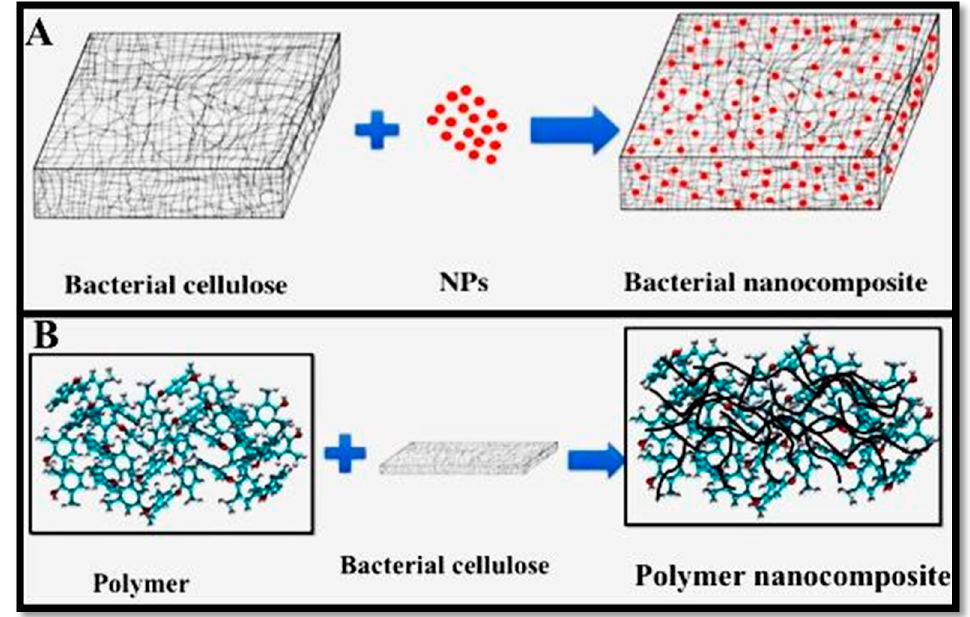
Figure 4. The use of BC as a ( A ) matrix or ( B ) reinforcement to prepare nanocomposites.